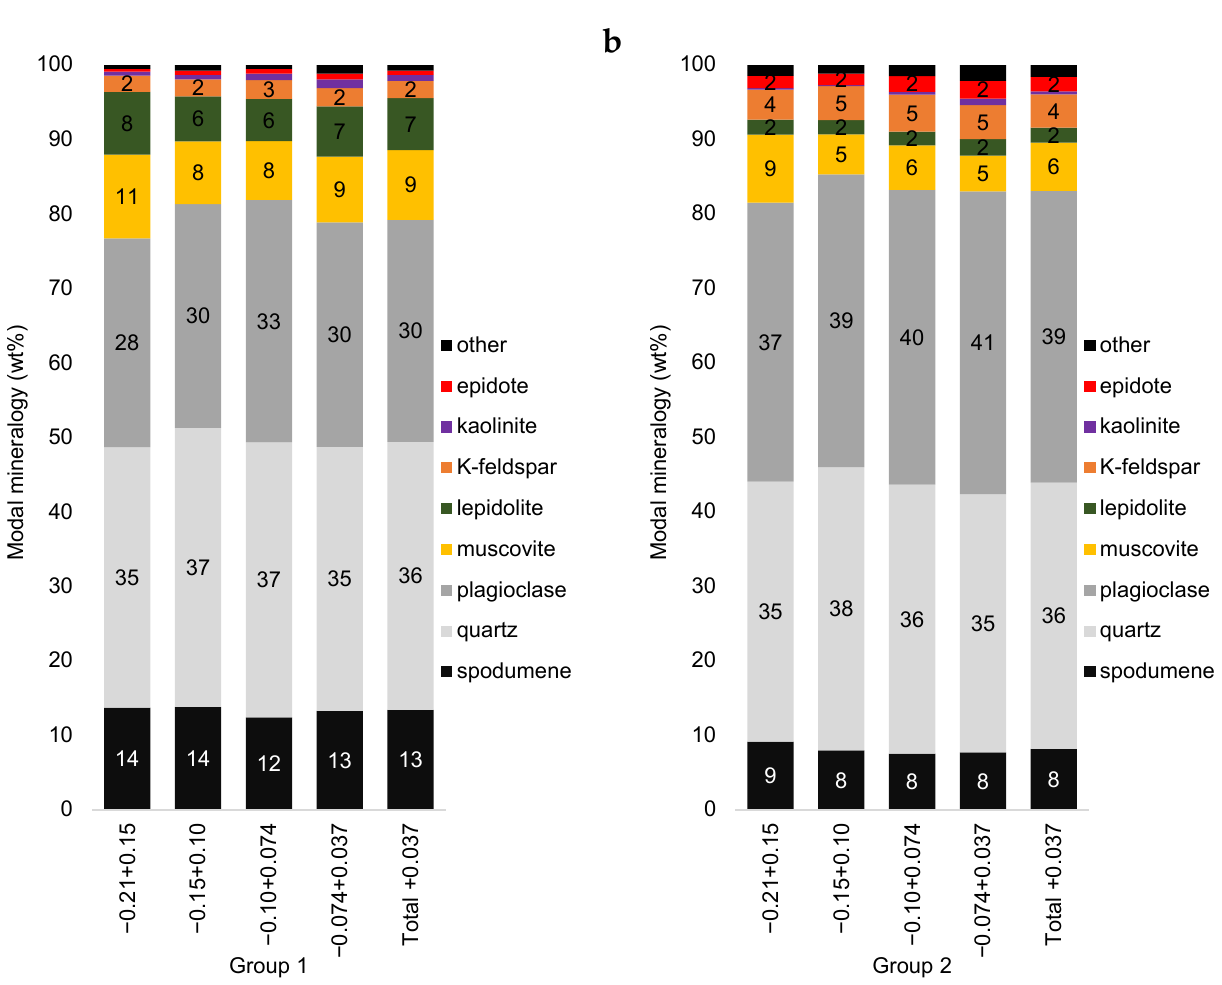
Figure 6. Modal mineralogy obtained by SEM-IA for G1 ( a ) and G2 ( b ).